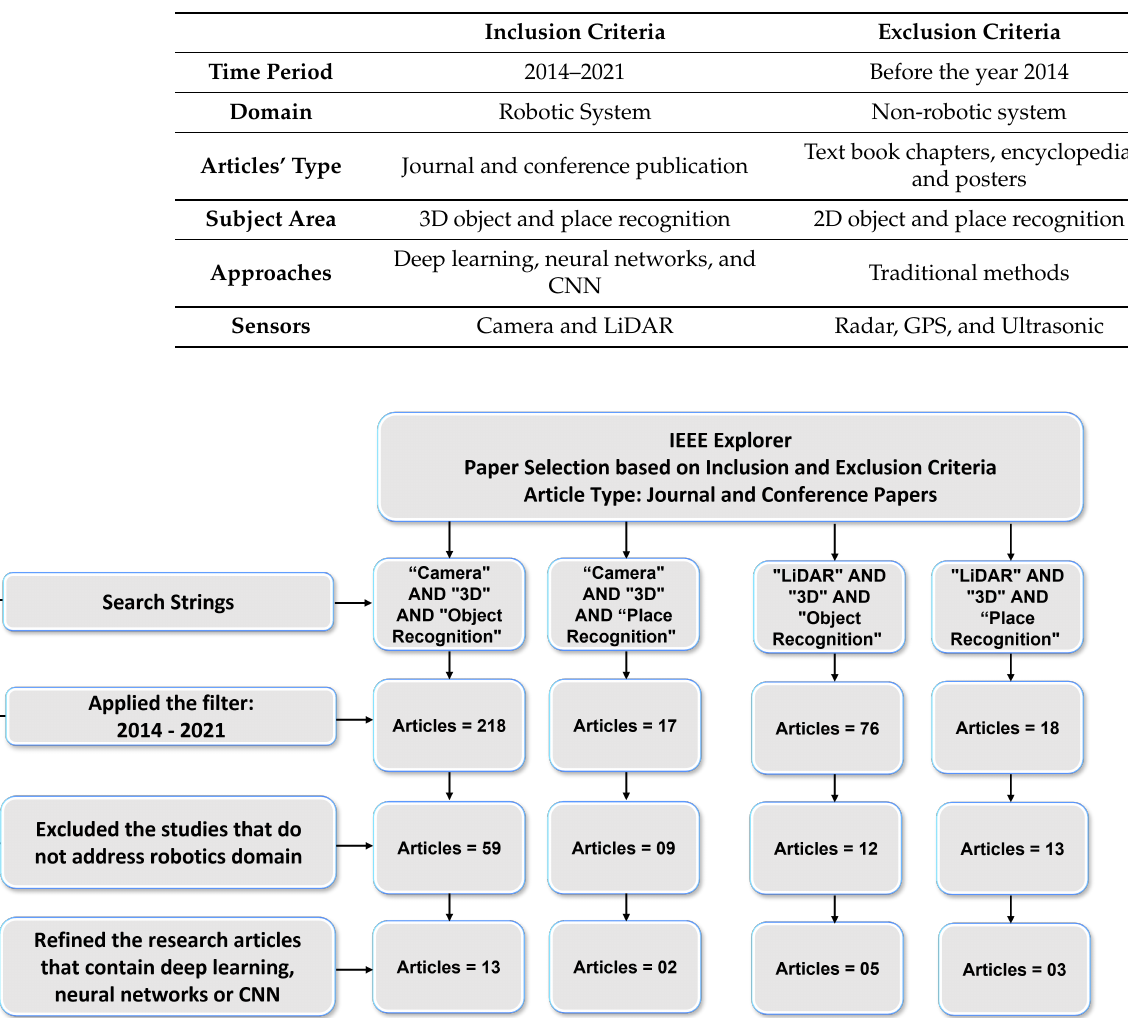
Figure 2. Results: IEEE Explorer paper selection based on the inclusion and exclusion